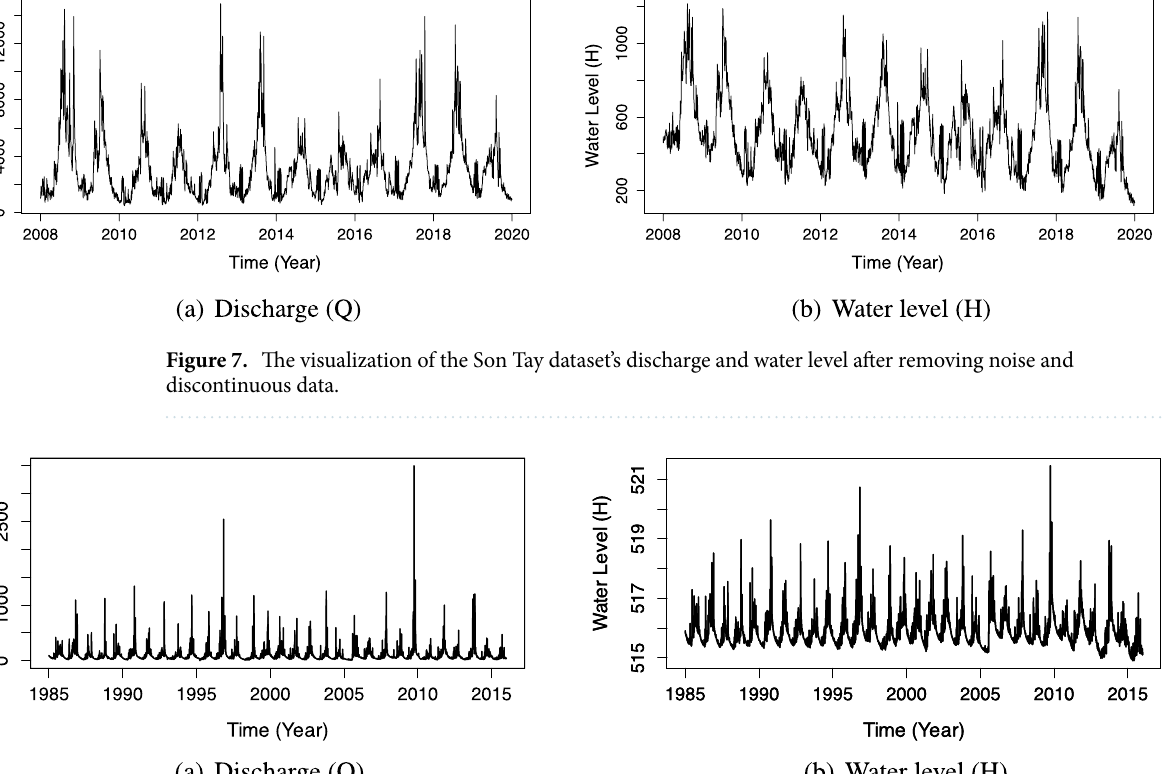
Figure 8. The visualization of the Kon Tum dataset’s discharge and water level after removing noise and discontinuous